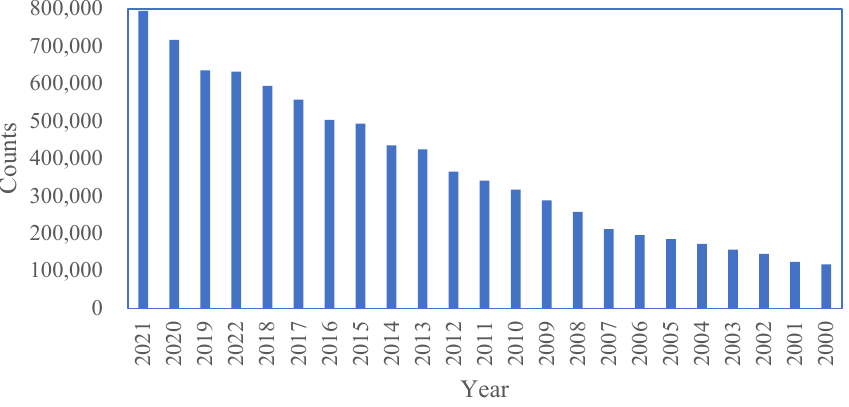
Figure 1. Retrieval result counts (from the Web of Science) based on the keywords (((TI = (building*)) AND TI = (environment*)) AND TI = (control* OR operate*)) OR TS = (health* OR comfortable* OR energy saving OR energy consumption).